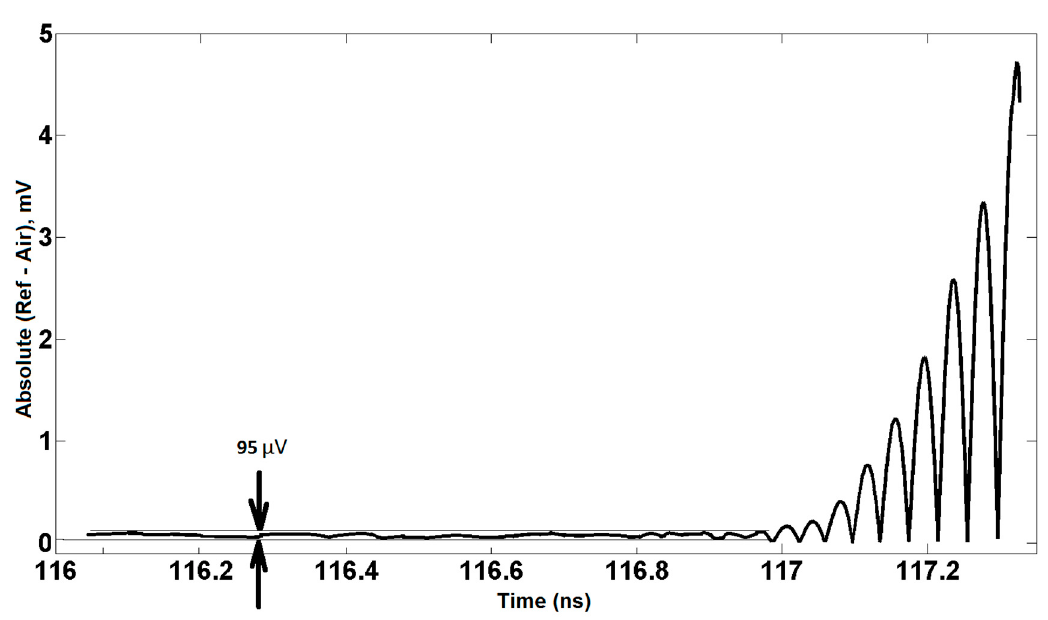
Figure 8. The real nose coinciding with the deviation between the two curves. Table 1. Experimental results for single-layer structures with compensating error sources in TRM.